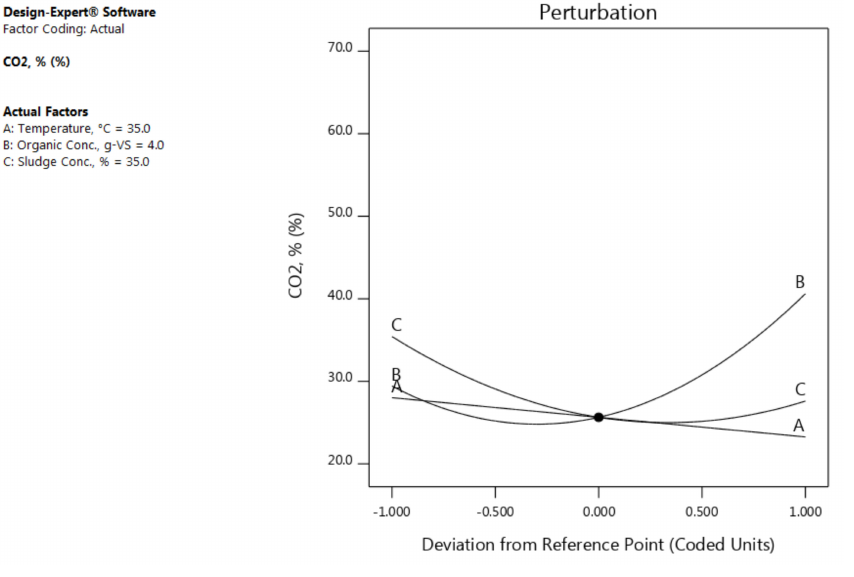
Figure 8. The Perturbation plot of the CO 2 %